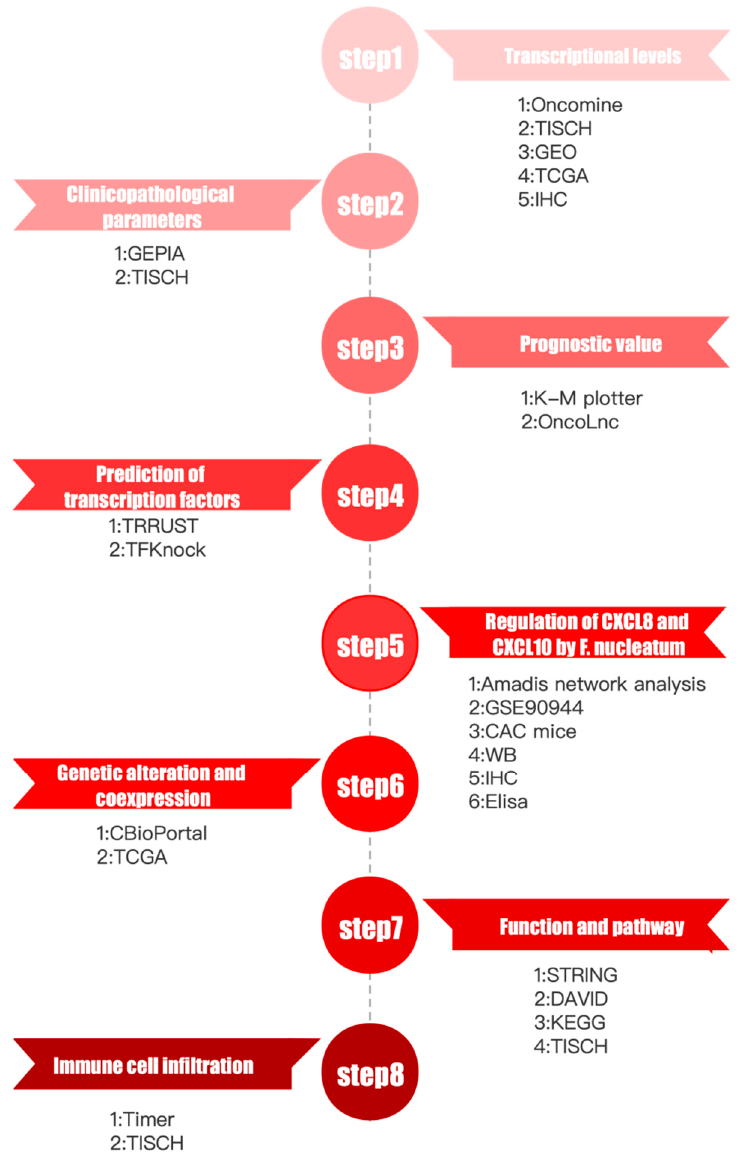
Figure 1. Analysis process and data processing of CXCs in 8 steps.